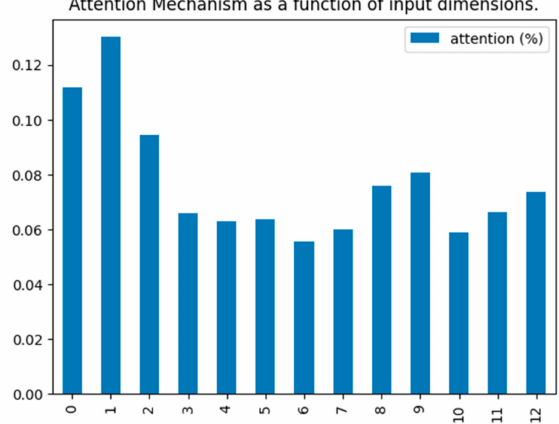
Figure 7. The attention values of the input